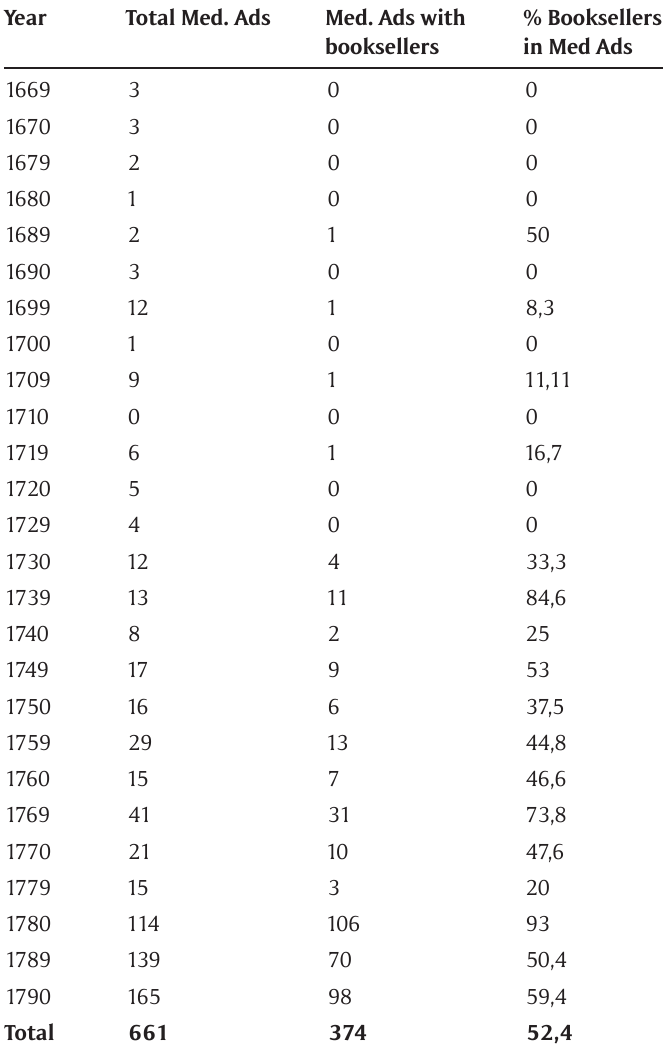
Table 3: Medical advertisements OHC with booksellers 1669–1790